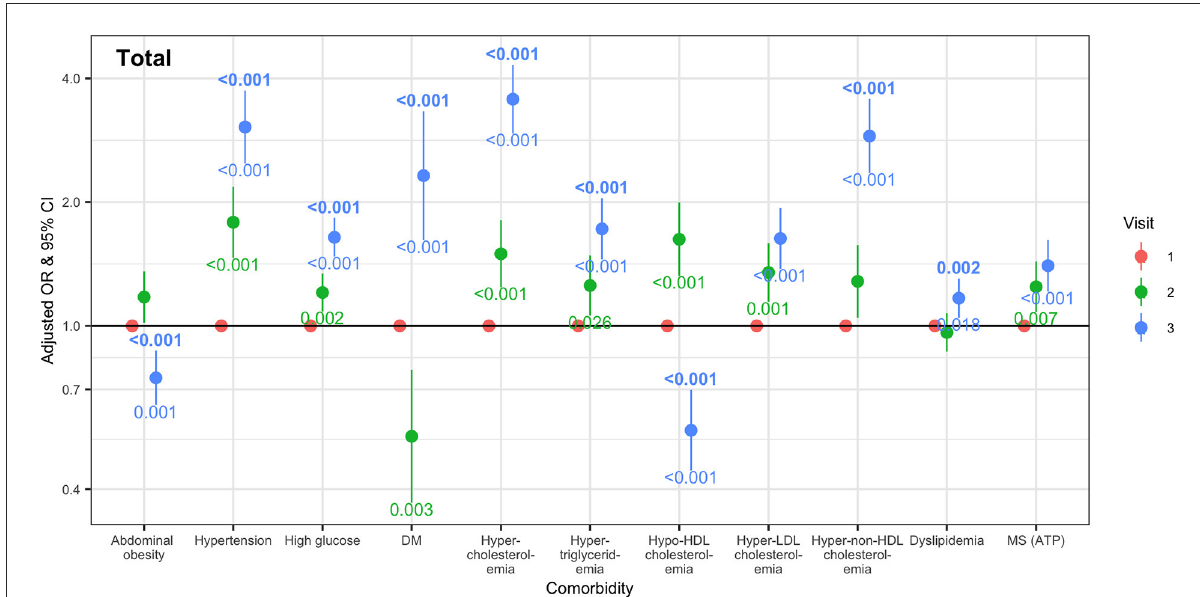
FIGURE3 Odd ratios and 95% confidence intervals for metabolic comorbidities at Visits 2 and 3 compared with Visit 1. Odd ratios and confidential intervals were calculated using a generalized linear mixed model, adjusted according to sex, age group, smoking, and alcohol drinking. The numbers above and below the odd ratios and confidential interval bars at Visit 2 and 3 are the result of post-hoc analysis using the Bonferroni method. DM, diabetes mellitus; HDL, high density lipoprotein; LDL, low density lipoprotein; MS, metabolic